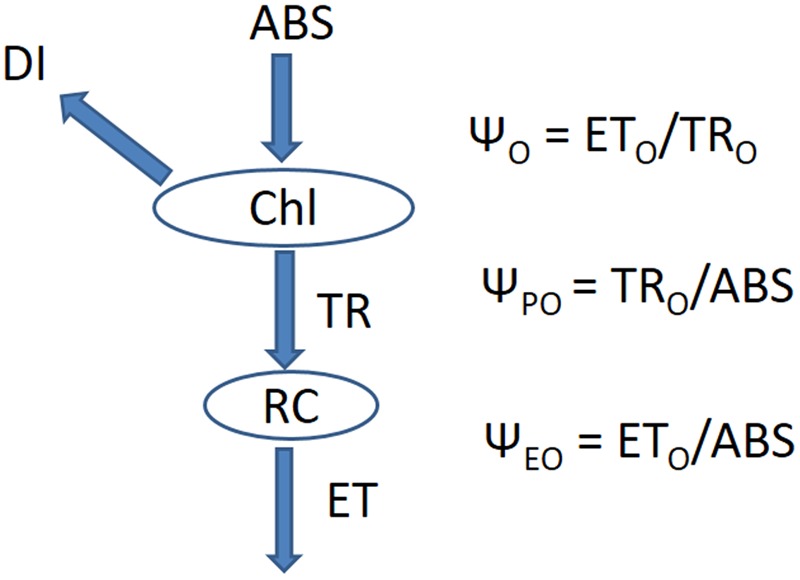
The energy cascade from light absorption to electron transport. Chl indicates chlorophyll, ABS indicates the absorption of energy, DI indicates the heat dissipation of energy, RC indicates the active reaction centers in the photosynthetic system, TR indicates the energy captured by the active reaction centers, ET indicates the energy for electron transport.